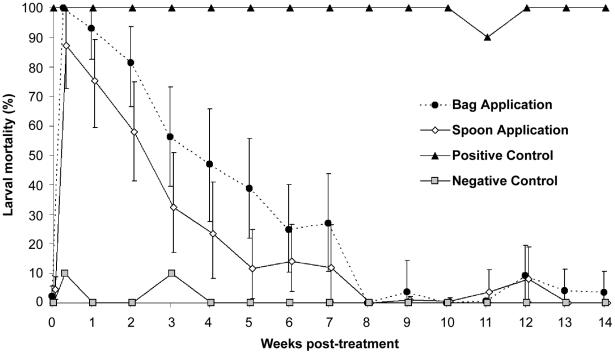
Larval mortality in the bioassays.Mean larval mortality over time after bag- or spoon-based application of temephos in the main trial, Clorinda 2008/2009. Error bars indicate 95% bootstrap confidence intervals. Bag- and spoon-based application curves have been displaced over the x axis to improve visualization.